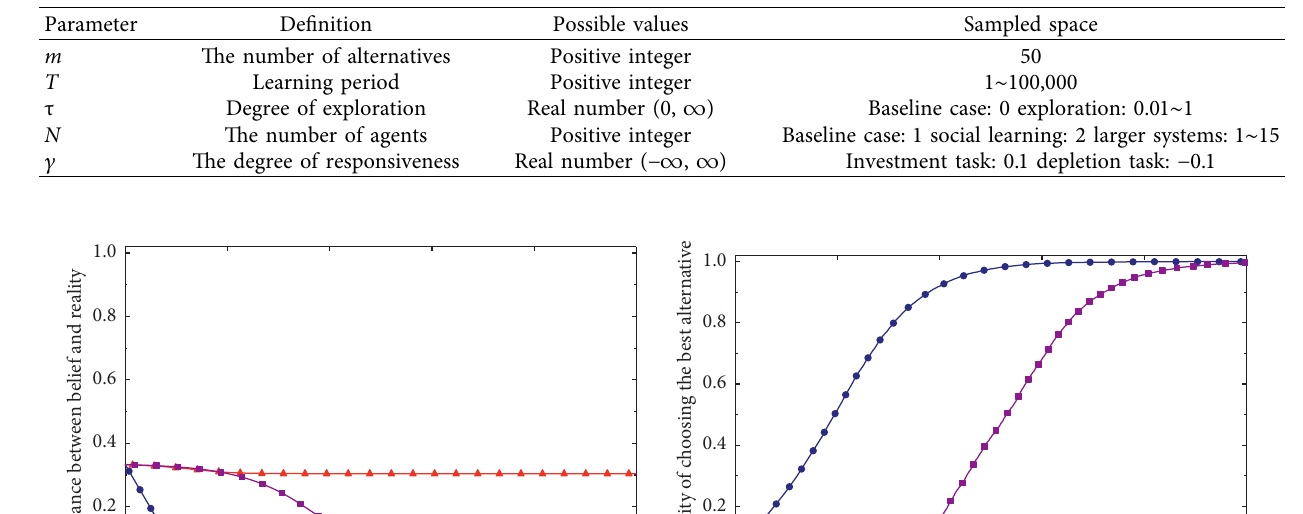
Table 2: Model parameters.